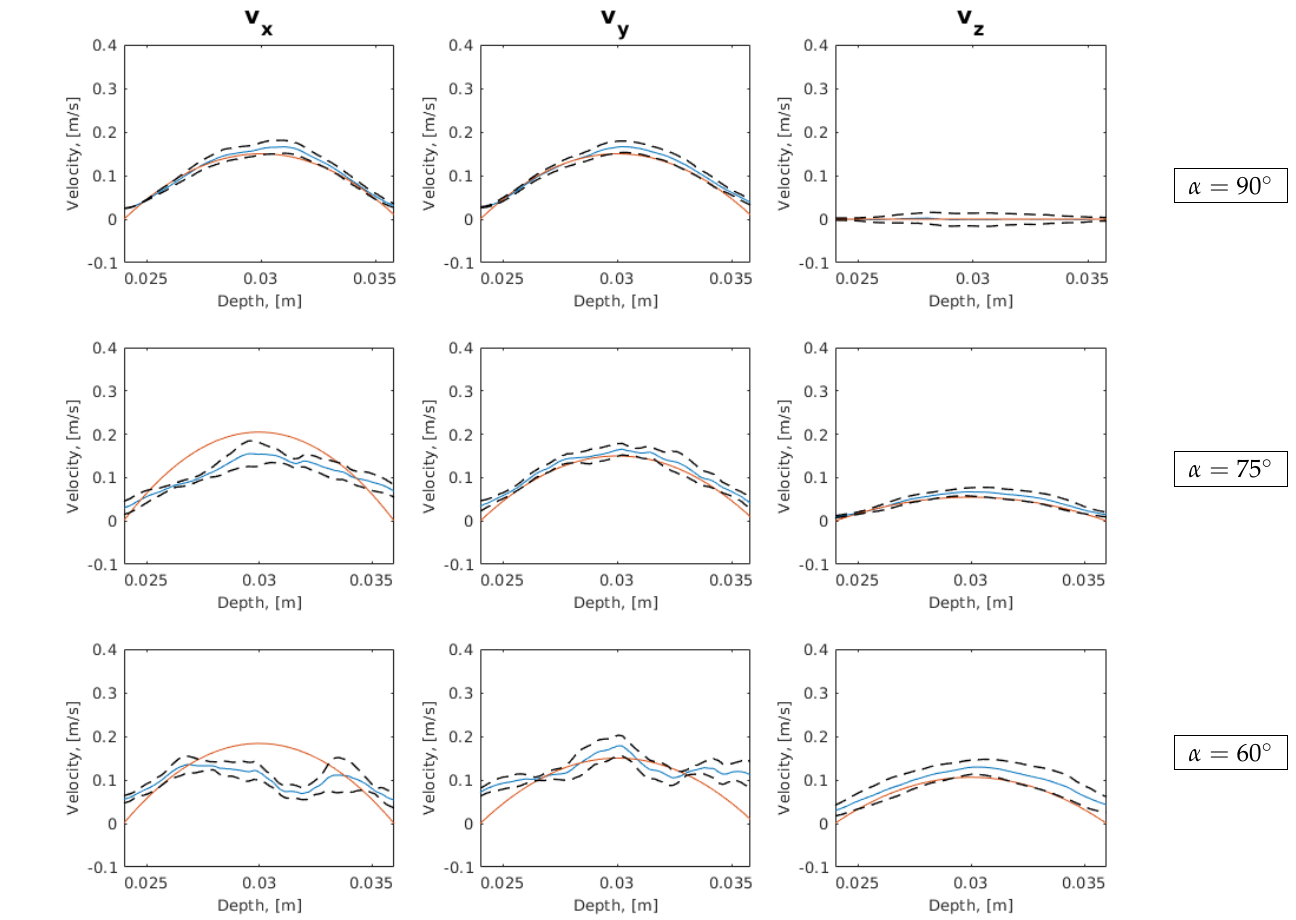
Figure 6. Estimated center profiles from simulated data for α = ( 60,75,90 ) ◦ , β = 45 ◦ . Standard settings from Table 1 were used. The red line is theoretical profile, the blue curve is estimated mean profile, the dashed black curves are the relative standard